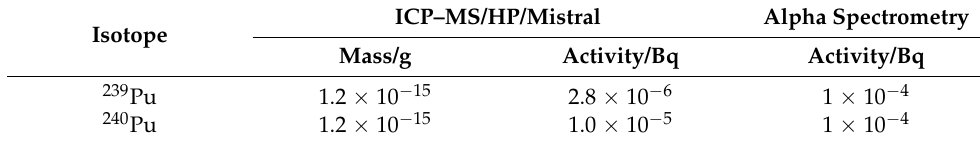
Table 8. Instrument detection limits of ICP–MS/HP/Mistral and alpha spectroscopy [90]. Isotope